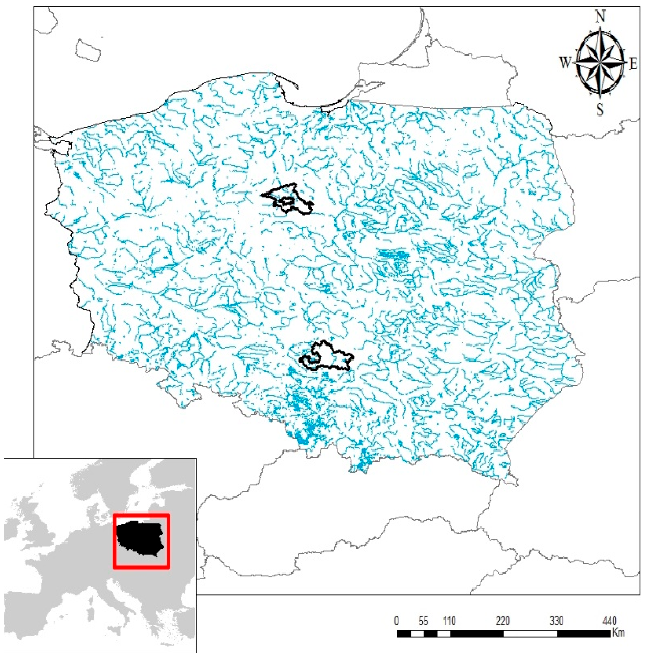
Figure 2. Study sites 1 (located in lower half of map) and 2 (located in upper half of map), along with system of major rivers in Poland (ArcGIS ® Esri, 2016).